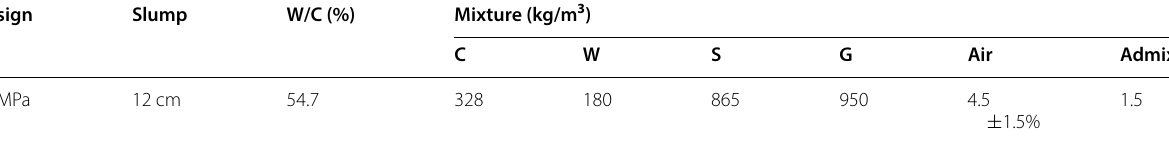
Table 5 Mix properties of concrete.